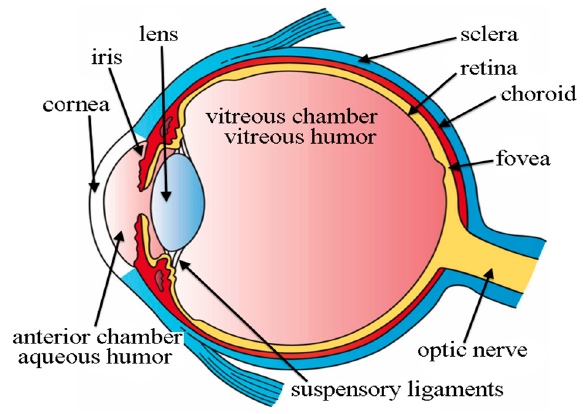
Figure 2. Basic Structure of Eye which are used in the diagnosis of AD [17].